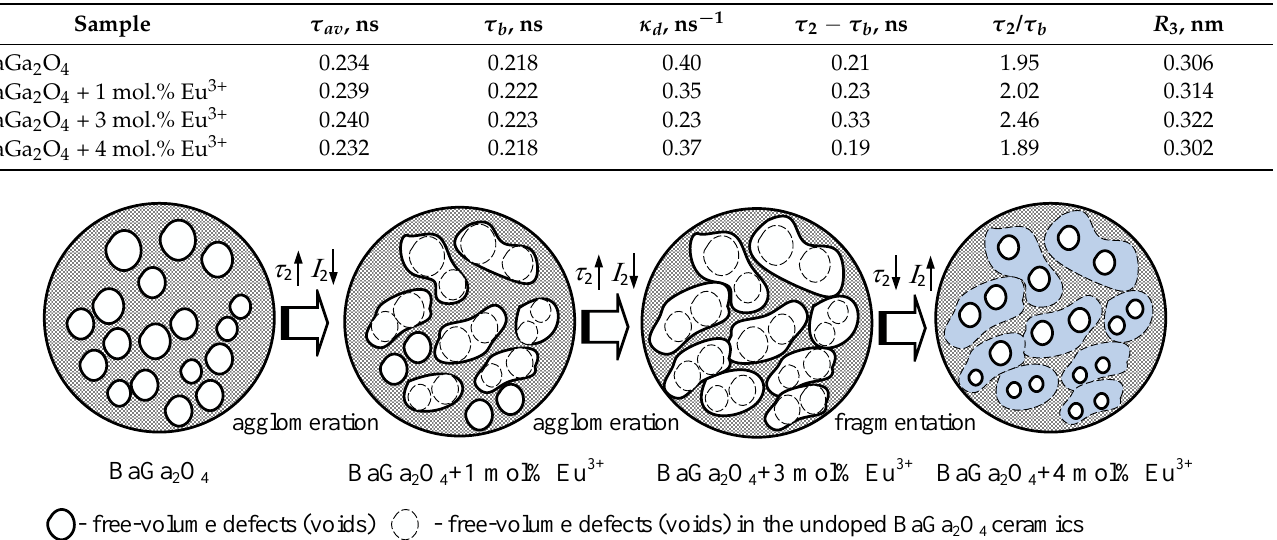
Table 4. Positron trapping parameters and nanopore radius for undoped and Eu 3+ -doped BaGa 2 O 4 ceramics. Sample